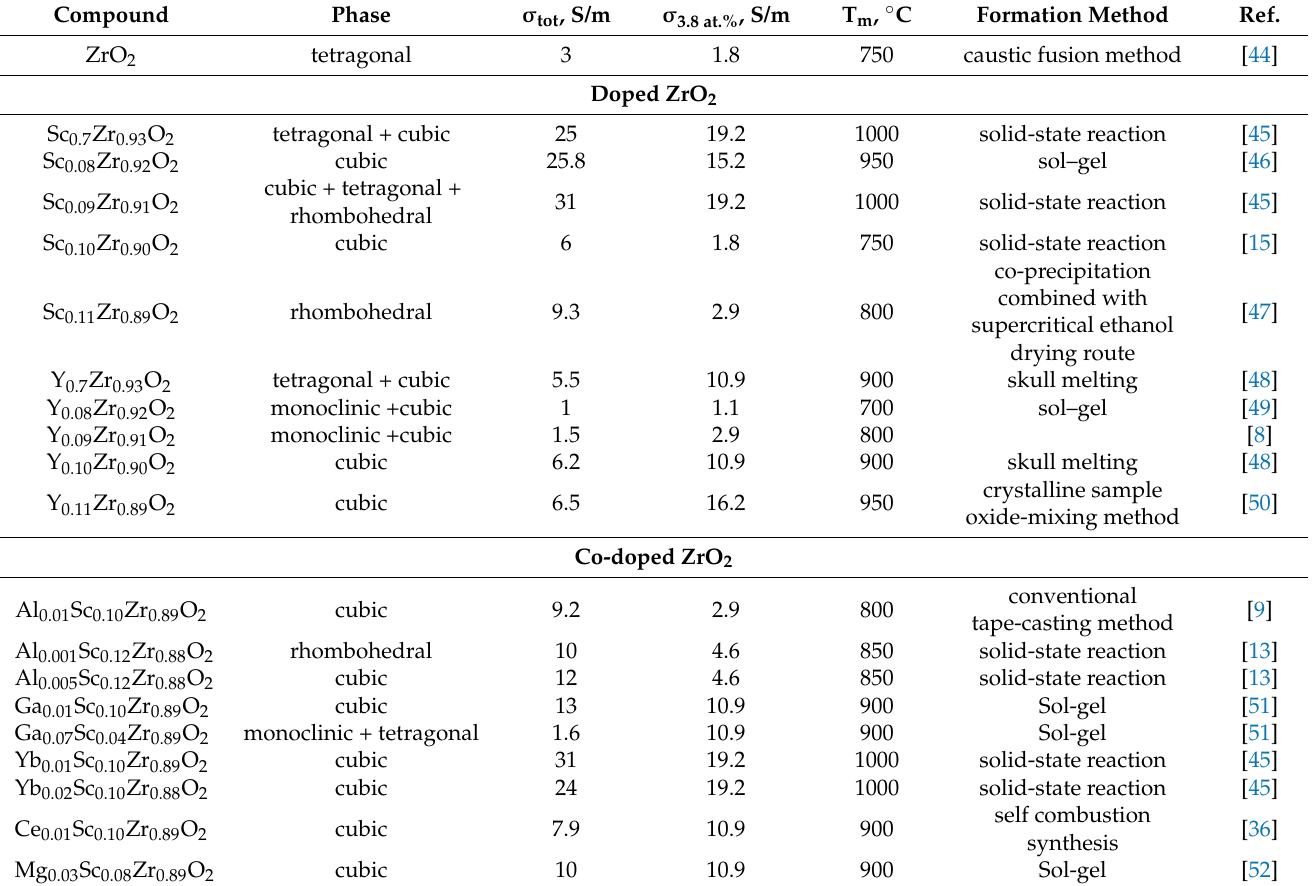
Table 4. Total conductivities of ZrO 2 based compounds ( σ tot ), highest total conductivities in our study ( σ 3.8 at.% ). Compound